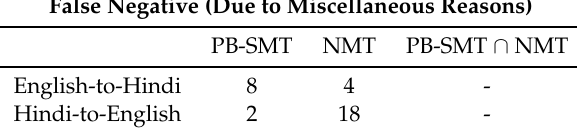
Table 10. False negatives in the PB-SMT and NMT tasks when TermEval fails to capture correct term translations for various reasons.